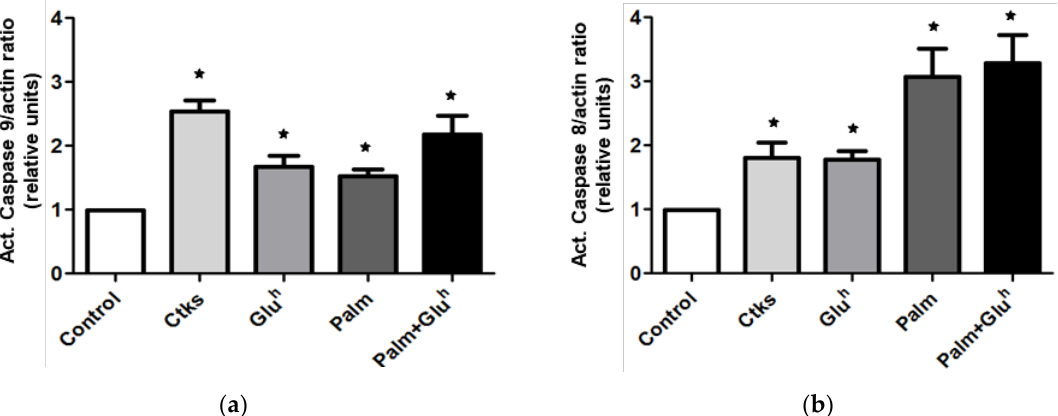
Figure 2. Cytokines, palmitate, high glucose, and high glucose+palmitate effect on caspase-9 and -8 activation. Active caspase-9 ( a ) and active caspase-8 ( b ) expression was measured by Western blotting in 48 h cultured 1.1E7 cells with or without the cited stimuli. The caspase/actin ratio was expressed as relative units to the control in both graphs. Values are represented as mean ± SEM of four independent experiments. * p < 0.05 with respect to the control condition.